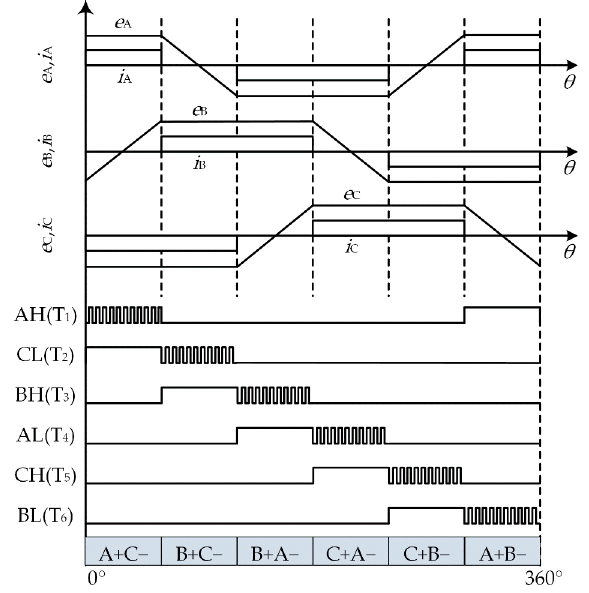
Figure 3. Ideal back EMFs, ideal phase current, and ON-PWM modulation method of the BLDCM. Assuming that the magnetic circuit of the motor is not saturated, ignoring the influence of the voltage drop of the power switch and its own structure, the voltage equation of the three-phase winding terminal of the BLDCM can be expressed as